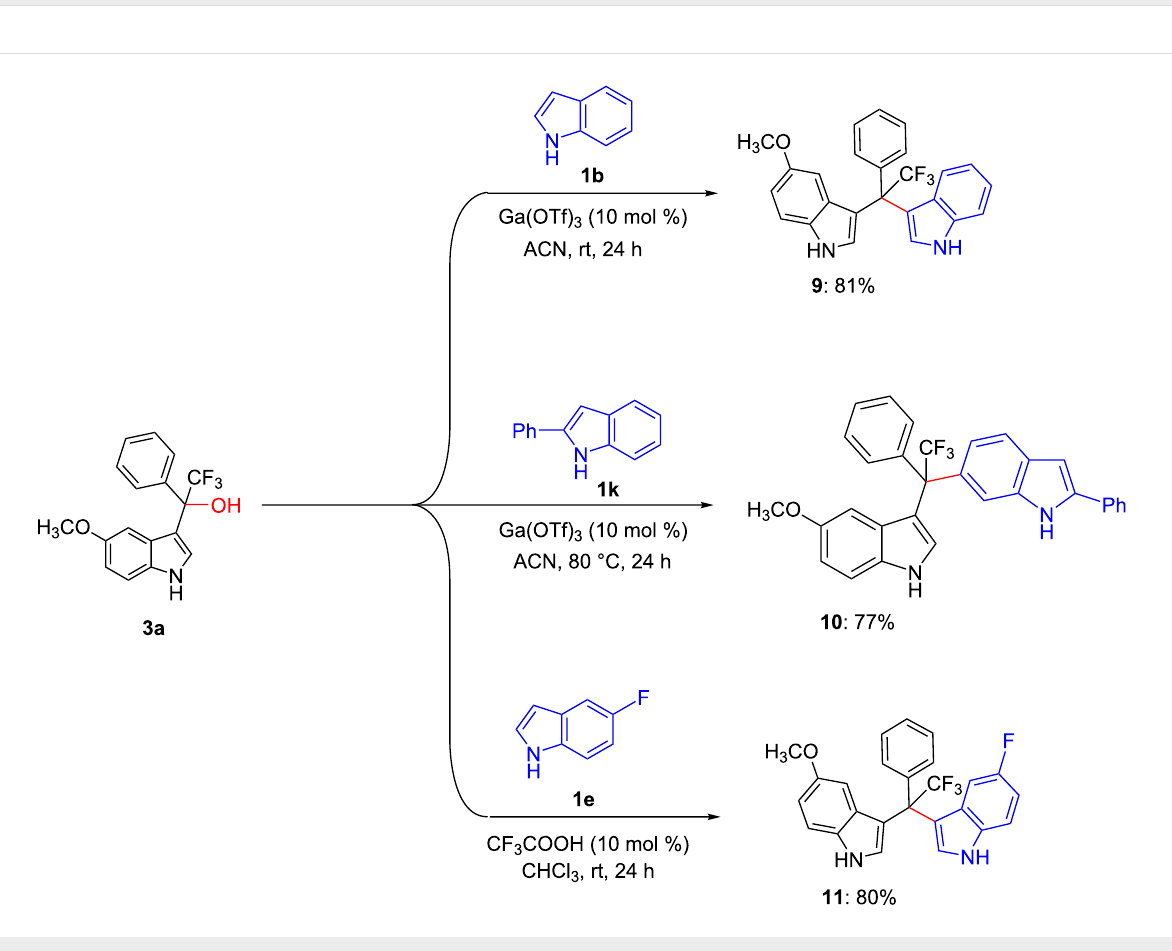
Figure 4: Recyclability of the catalytic system n- Bu 4 PBr/K 2 CO 3 for the preparation of 2,2,2-trifluoro-1-(5-methoxy-1 H -indol-3-yl)-1-phenylethan-1-ol ( 3a ).